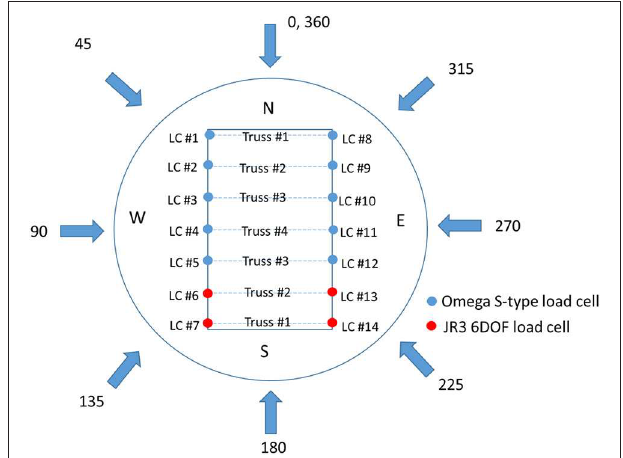
FIGURE 6 | The convention for wind directions, location of load cells and truss